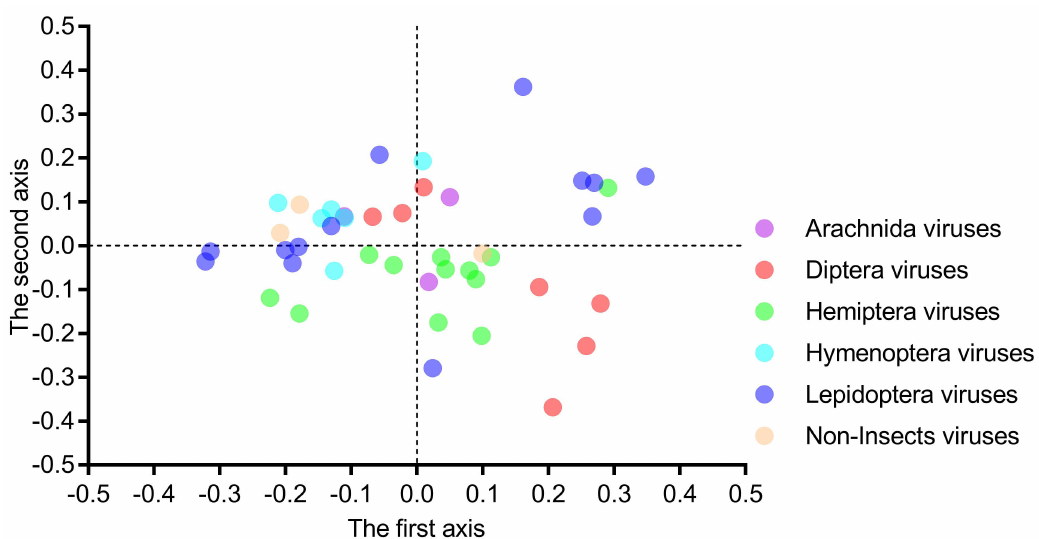
Figure 7. Both the first and second axes of the correspondence analysis failed to clearly separate the six viral group members, indicating that the factors influencing the codon usage in iflaviruses are independent of viral host taxa. Each dot represents a genome corresponding to the two coordinate axes. The two dashed lines indicate zero variations in the